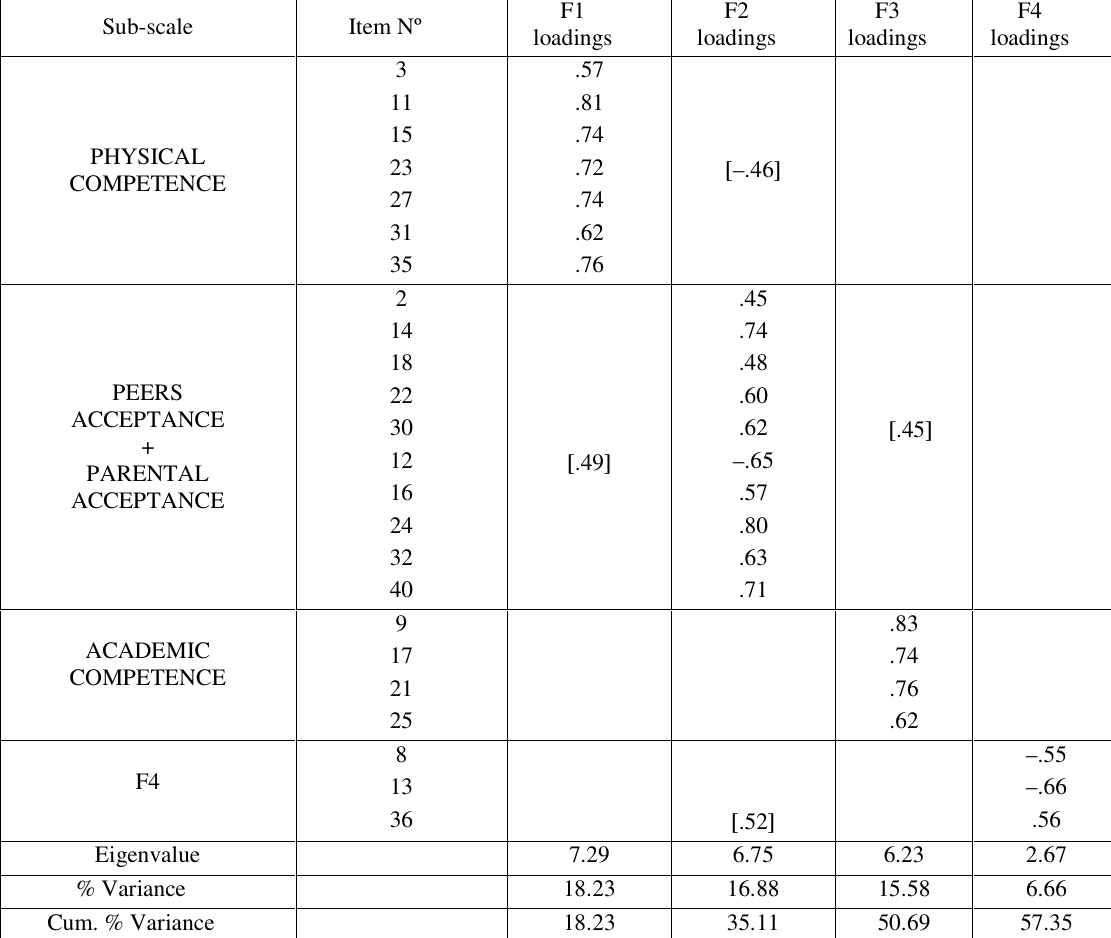
Principal components factor loadings for PSPCSAp items – students with DS (n = 47) Sub-scale